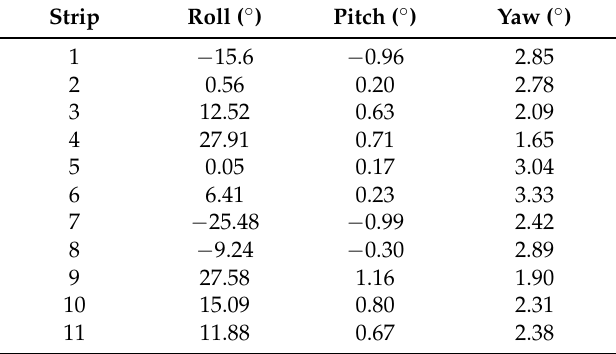
Table 2. Attitude angles of Kompsat-3 test data used for the AOCS (attitude and orbit control subsystem) absolute